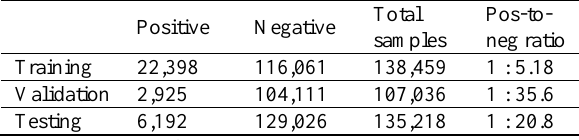
Table 1. Number of training, validation and testing samples. Fig. 4 shows 5 positive and 5 negative training samples. Magenta indicates the building changes which are either new or heightened. Cyan indicates a demolished or lowered building. Yellow indicates data gaps in either laser points or dense matching